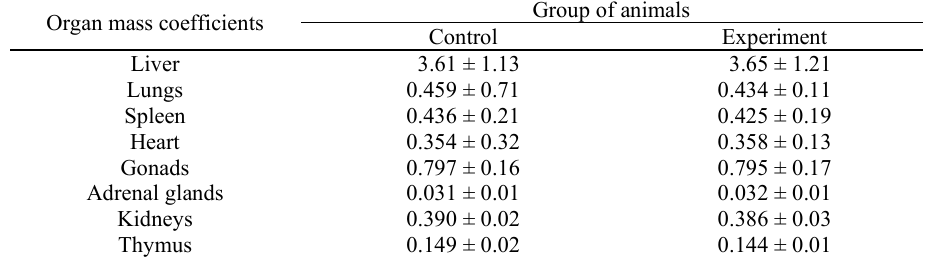
Weight coefficients of internal organs of white rats after a single intragastric administration of the drug (М ± m, n = 5)